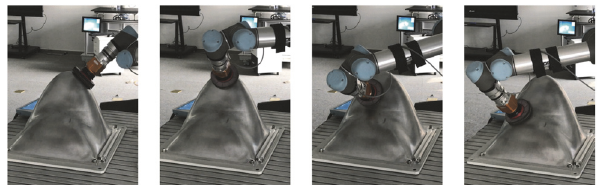
Figure 9: The GMM and GMR learning for one path polishing. Left: the demonstrations for the polishing path are repeated 5 times. Middle: GMM is trained to approximate the joint probability ̂𝐹) distribution 𝑝(𝛼, by EM algorithm using BIC for 5 Gaussian components. The green cross marks refer to the mean of each Gaussian model. Right: GMR policy is derived based on the GMM; the blue region is the the 3𝜎 confidence interval of the contact force distribution.